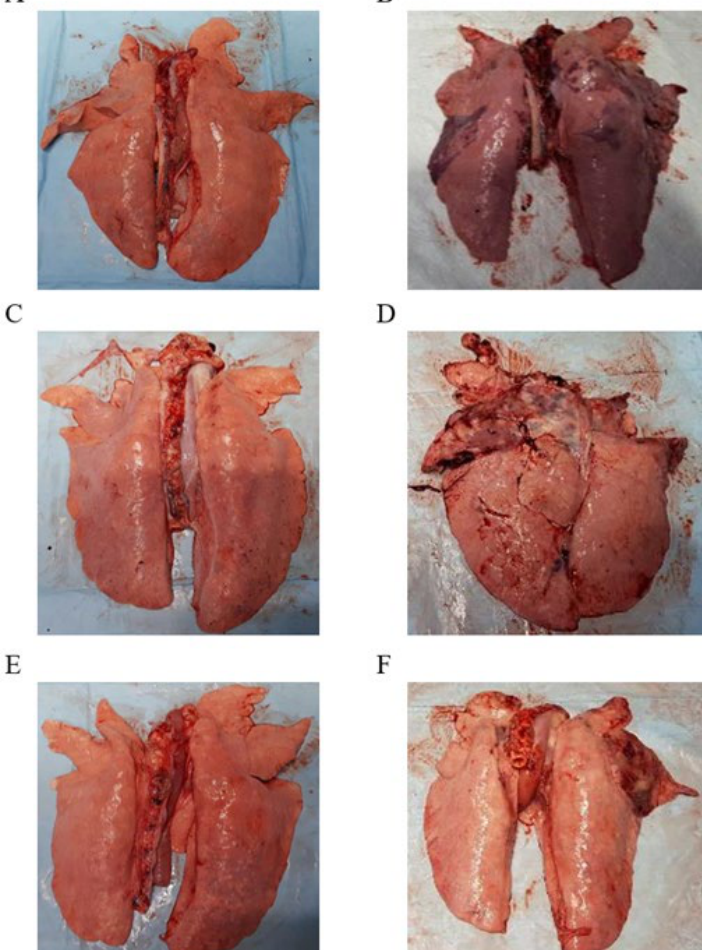
Fig. 5. Gross lung lesions of pigs after challenge with virulent App strains. Lungs of pigs in the negative control group, nonchallenged (A) and challenged (B); lungs of pigs in the commercial vaccine group, nonchallenged (C) and challenged (D); lungs of pigs in the test vaccine group, nonchallenged (E) and challenged